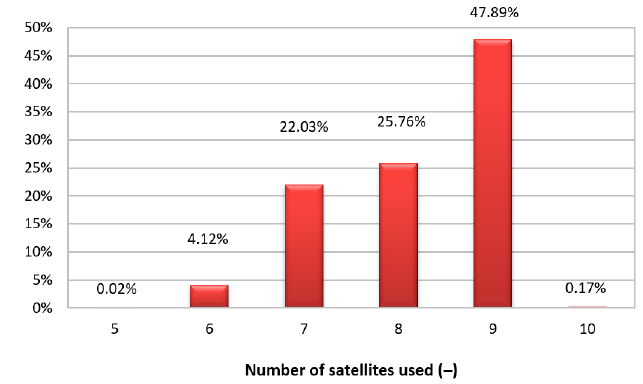
Figure 3. The number of satellites used by the DGPS receiver to determine the position coordi- nates.